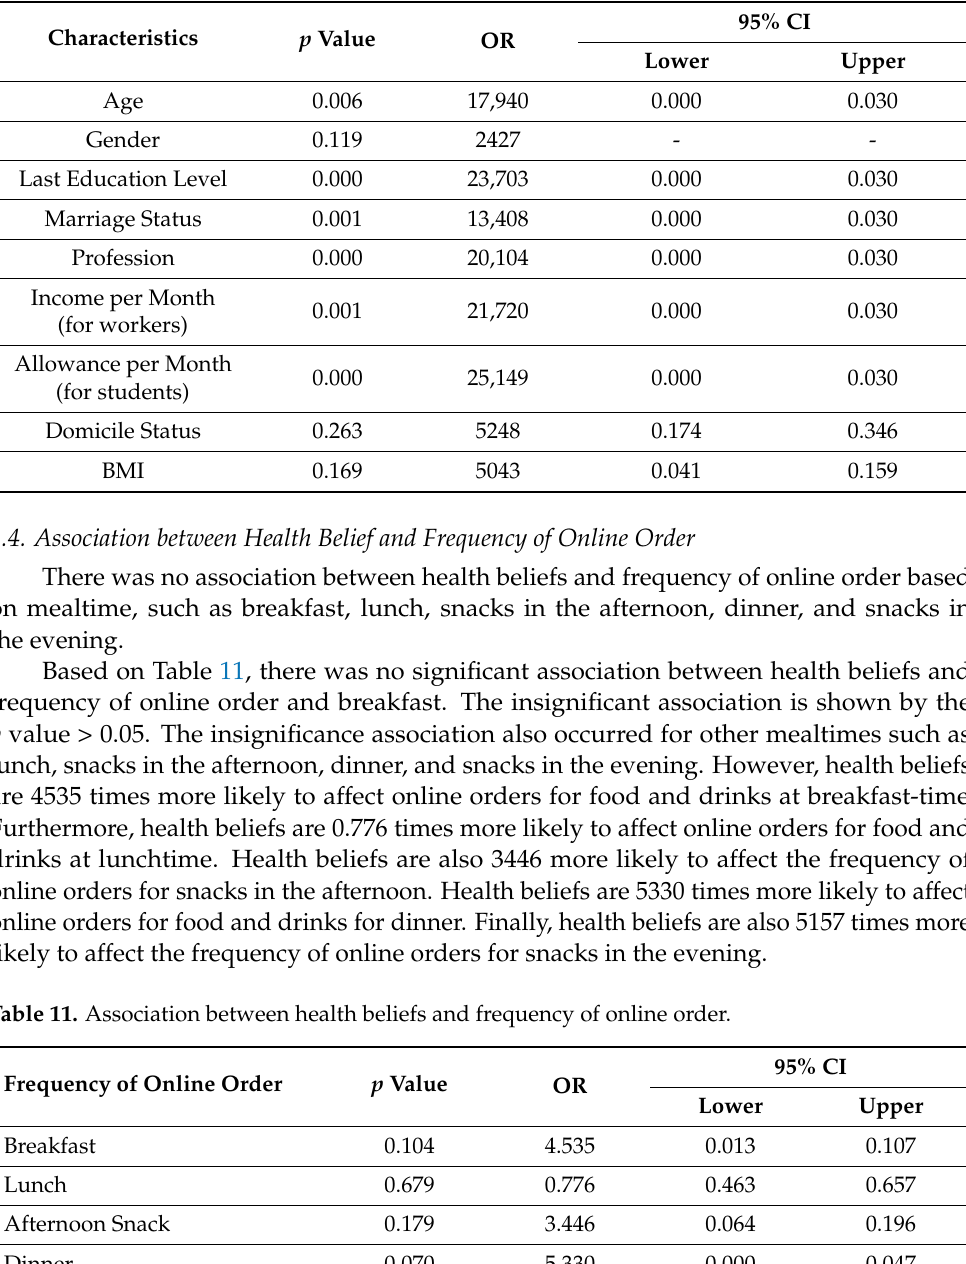
Table 10. Association between characteristics and health belief.